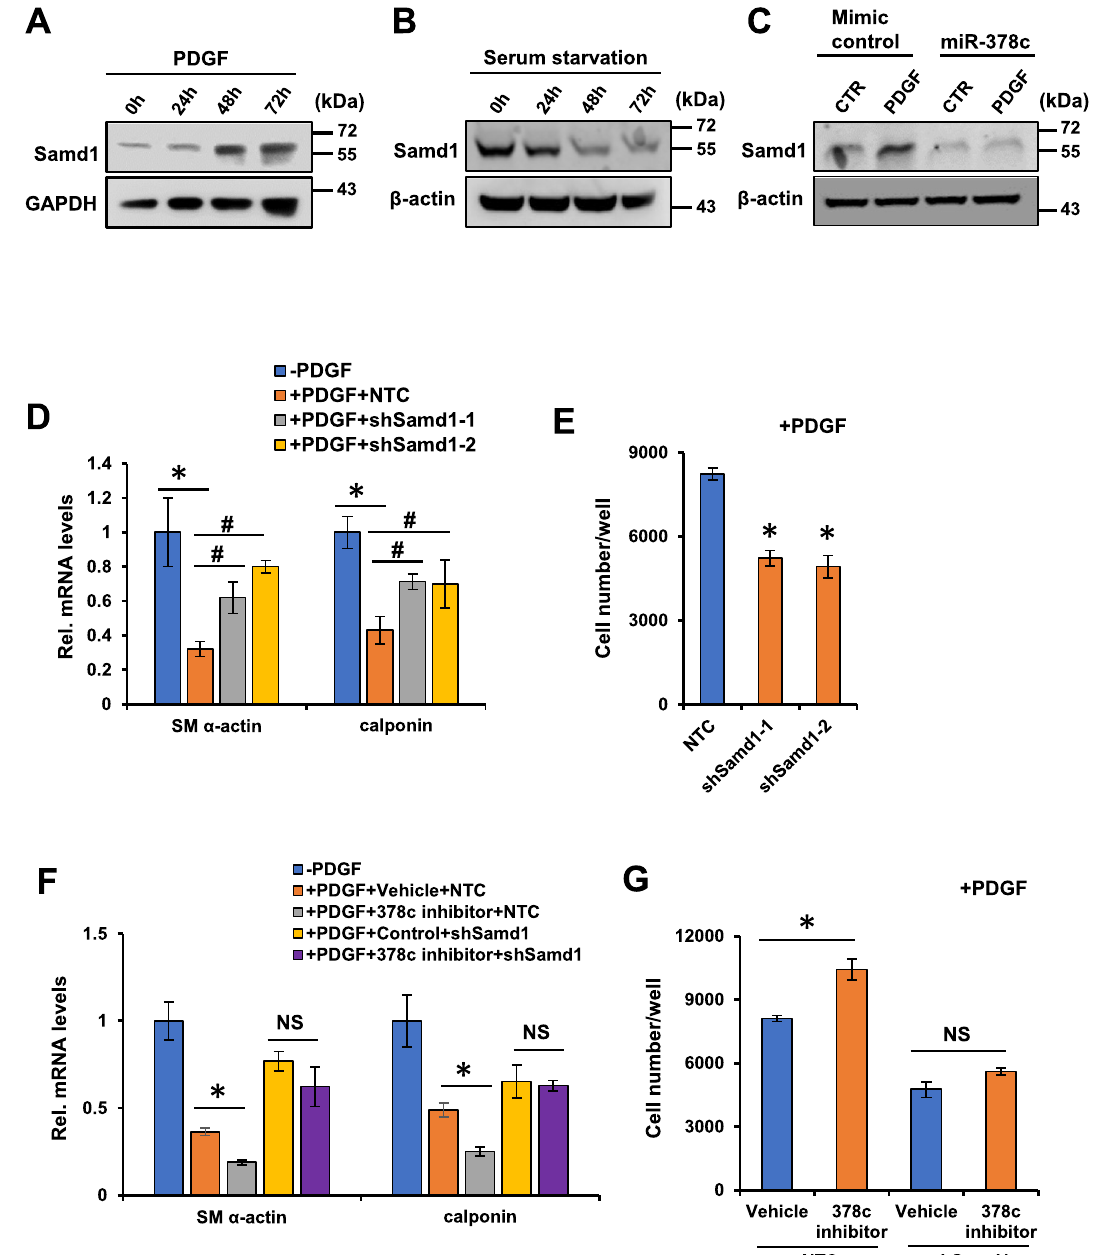
Figure 4. miR-378 controls VSMCs phenotypic modulation thought Samd1. ( A ) Western blot analysis of Samd1 expression in VSMCs stimulated with PDGF-BB. β-actin serves as a loading control. ( B ) Western blot analysis of Samd1 expression in VSMCs stimulated with serum-starvation (0.1%). β-actin serves as a loading control. ( C ) VSMCs stimulated with PDGF-BB were further transfected with miR-378c mimic, followed by western blot analysis of Samd1 expression. β-actin serves as a loading control. ( D ) VSMCs stimulated with PDGF-BB were further transfected with Samd1 shRNA or NTC, VSMCs differentiation markers were analyzed by qRT-PCR. Data were presented as mean ± SD, n = 4. *P < 0.05 as compared with non-PDGF treated group; # P < 0.05 as compared with PDGF-treated NTC group. ( E ) PDGF-BB stimulated VSMCs were further transfected with Samd1 shRNA or NTC, cell numbers were determined. Data were presented as mean ± SD, n = 4. *P < 0.05 as compared with PDGF-treated NTC group. ( F ) PDGF-BB stimulated VSMCs treated with miR- 378c inhibitor were further transfected with Samd1 shRNA or NTC, followed by qRT-PCR analysis of VSMC differentiation markers. Data were presented as mean ± SD, n = 4. *P < 0.05 as compared between the indicated group. ( G ) PDGF-BB stimulated VSMCs treated with miR-378c inhibitor were further transfected with Samd1 shRNA or NTC, cell numbers were determined. Data were presented as mean ± SD, n = 4. *P < 0.05 as compared between the indicated